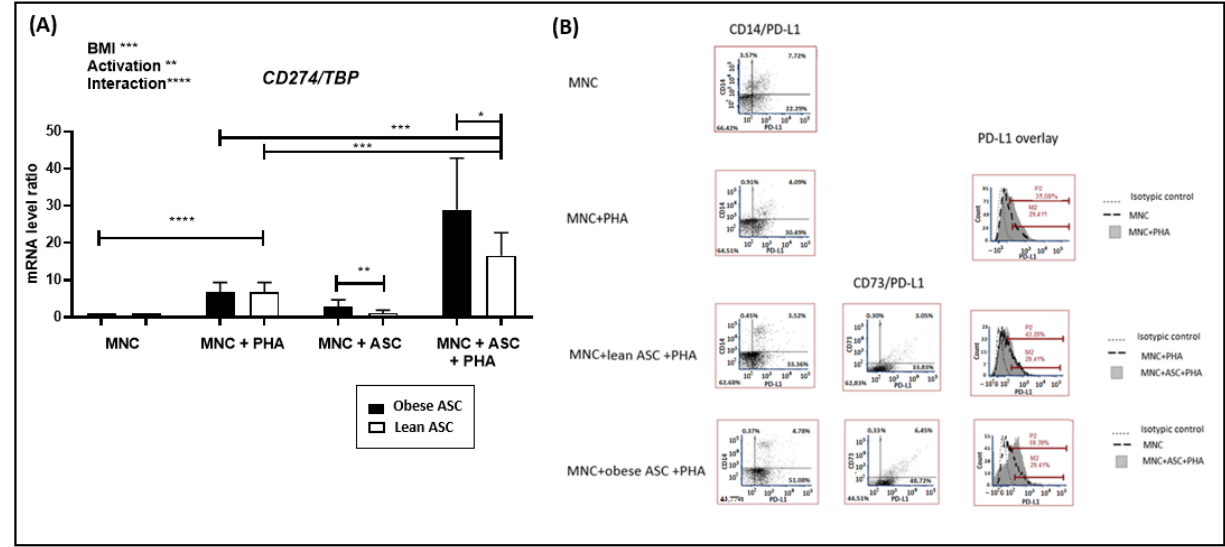
Figure 2. Inflammation, mediated by adipose-tissue-derived mesenchymal stem cells (ASC) from obese individuals, contributes to PD-L1 upregulation in cocultures with mononuclear immune cells. MNC were activated by PHA in the presence or absence of ob-ASC or lean ASC. ( A ) CD274 ( PDL1) mRNA expression levels were measured by RT-qPCR. Results are expressed as a ratio relative to the TBP housekeeping gene. Two-way ANOVA with Fisher’s LSD comparison tests were used. Data are the mean ± SD of n = 4. ****, ***, **, and * represent a p -value <0.0001, <0.001, <0.01, or <0.05, respectively. ( B ) Membrane expression of PD-L1 was measured by flow cytometry in cells stained for CD14 or CD73. Results are representative of two experiments with two different ASC.